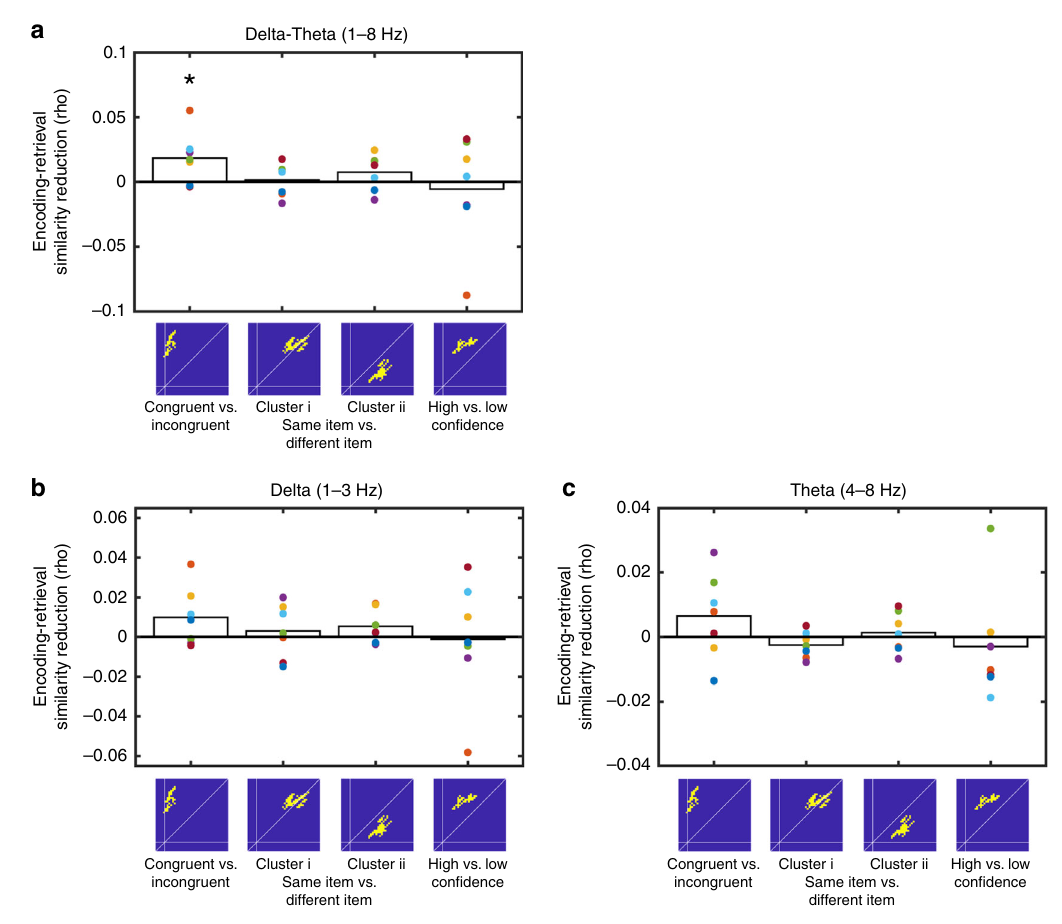
Fig. 4 Frequency-speci fi c reinstatement in HC and LTC. a Results from jackknife procedure showing signi fi cant reduction of hippocampal context reinstatement after excluding 1 – 8 Hz activity, while item-speci fi c reinstatement and con fi dence effects in lateral temporal cortex were not affected. Bar plots indicate changes in encoding-retrieval similarity in the main contrasts and clusters after excluding 1 – 8 Hz activity. * in panel a indicates reductions in ERS values that are signi fi cantly different from zero across the group at p < 0.05. b , c Reduction of encoding-retrieval similarity in relevant temporal regions of interest after the removal of delta (1 – 3 Hz; panel b ) and theta (4 – 8 Hz; panel c ) activity. While reductions were numerically higher in the hippocampal congruent-incongruent cluster, no signi fi cant differences were